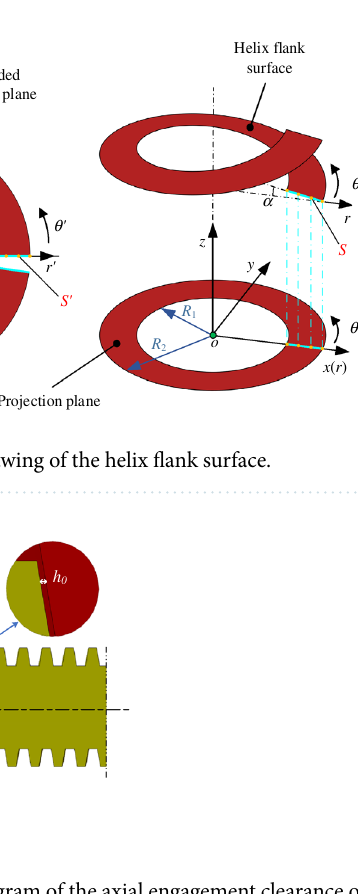
Figure 5. Schematic diagram of the axial engagement clearance of the hydrostatic lead